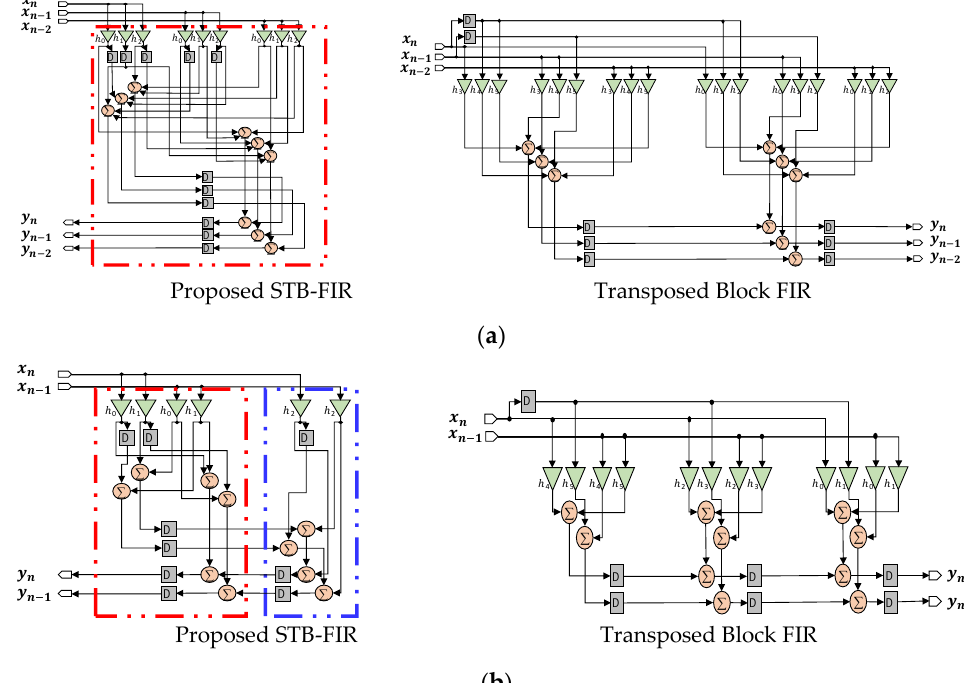
Figure 7. Comparisons of parallel FIR implementations (proposed STB-FIR vs. transposed block FIR). ( a ) Implementations of a 6-tap 3-parallel FIR (T = 6, L = 3 and M = 2) and ( b ) implementations of a 6-tap 2-parallel FIR (T = 6, L = 2 and M =